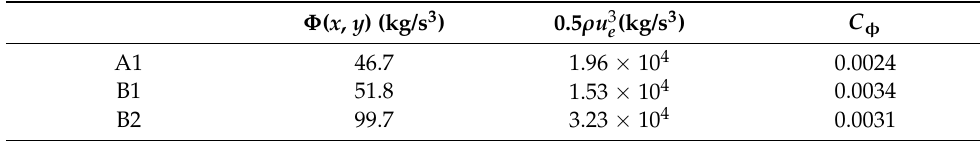
Table 4. Decomposition of local dissipation rates φ